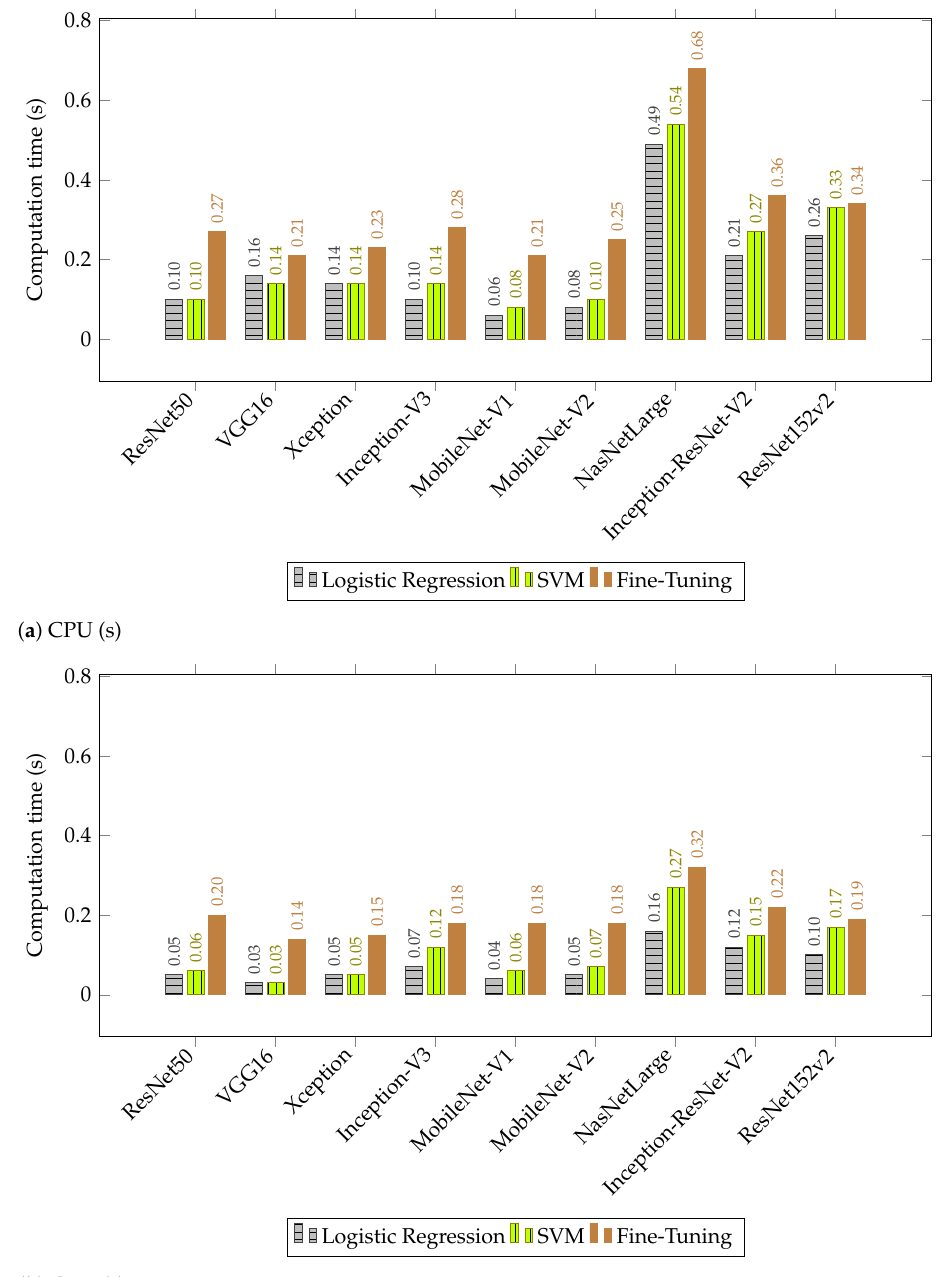
Figure 4. Time comparison of the results obtained in our proposed pipeline using the CPU ( a ) and the GPU ( b